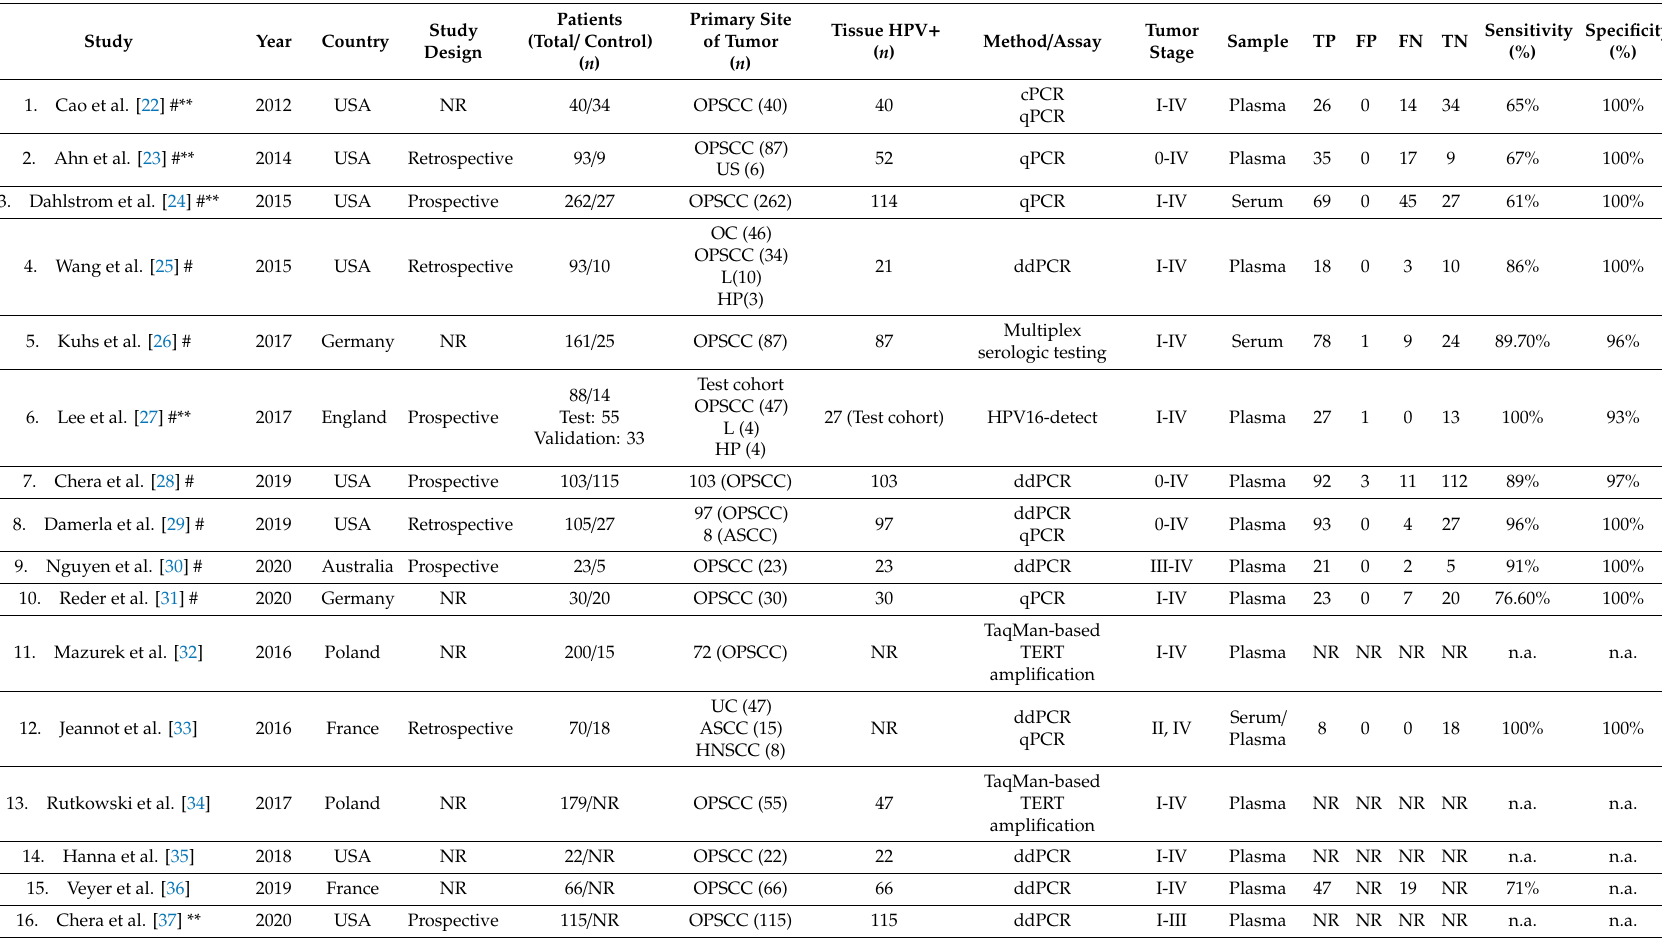
Table 1. Summary of all 16 studies assessing blood cfHPV-DNA in HPV-related OPSCC included in review and